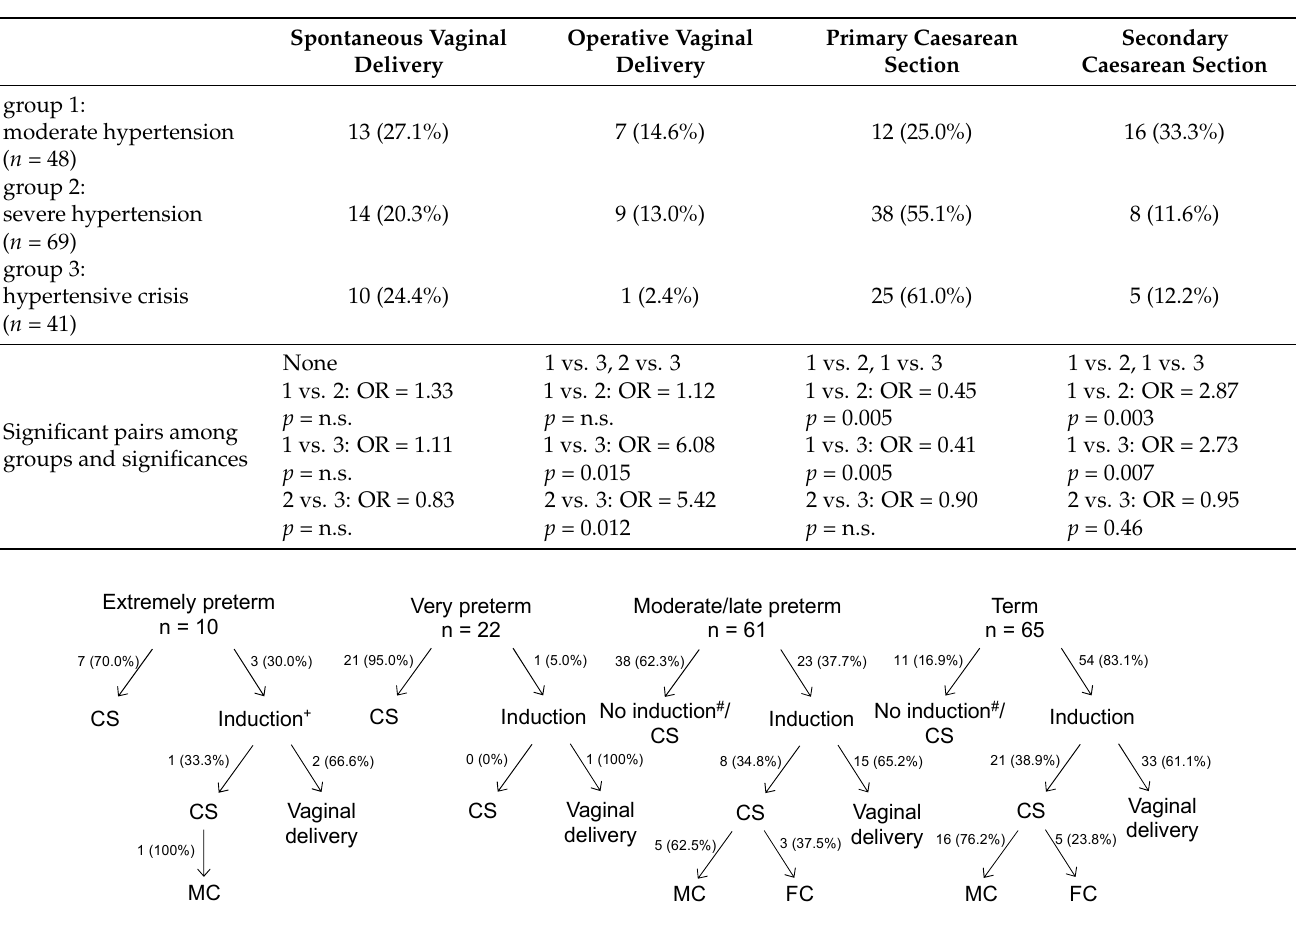
Table 4. Maternal blood pressure levels in association with the mode of delivery.